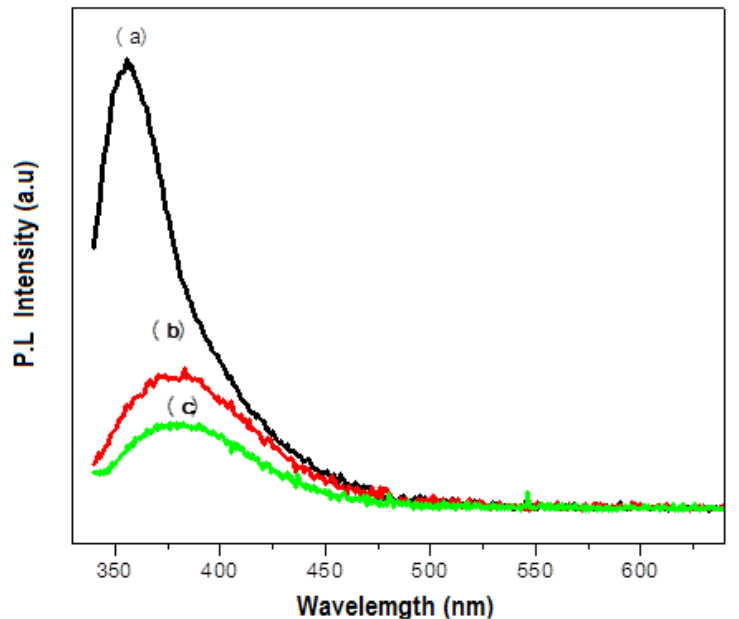
Figure 10. Photoluminescence spectra of ( a ) PANI, ( b ) doped PANI and doped-PANI/SWCNTs composite at 2.1% concentration ( c ).